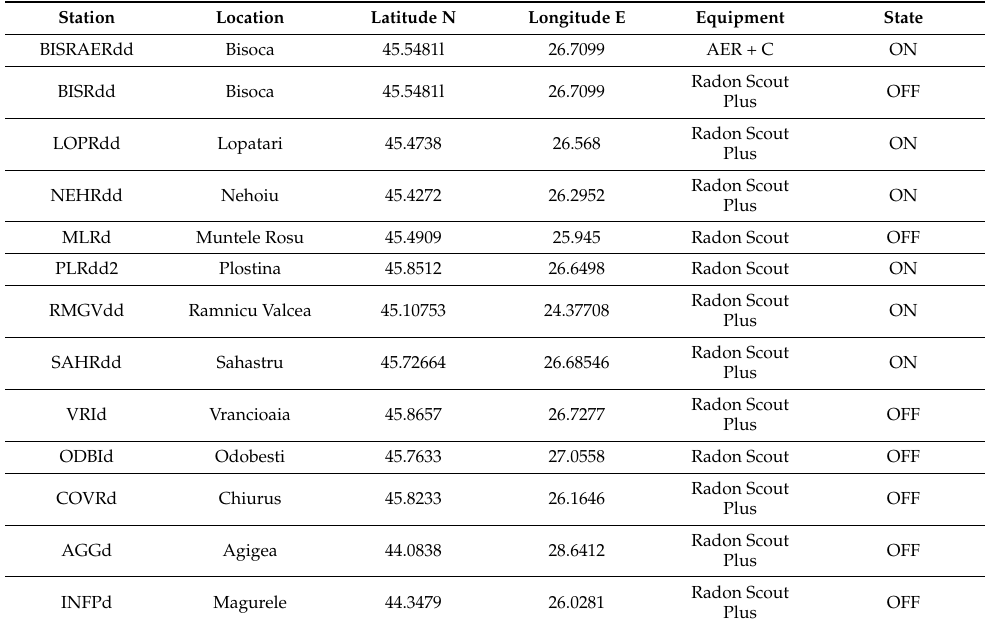
Table 1. Radon network stations.